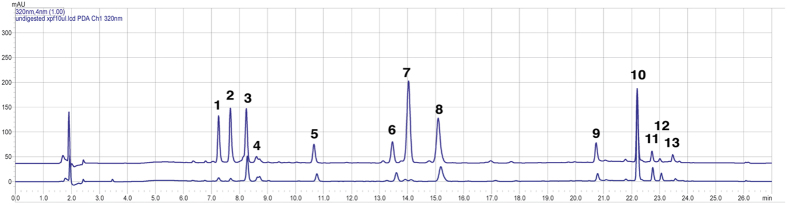
Identification of extractable constituents of A. thaliana mutant xpf3 extract, pre- and post-treatment with liver microsomes.HPLC traces of the constituent chemicals from xpf3 extracts pre and post-liver microsome (LM) treatment yielded component peaks (numbered 1–13). The upper trace is analysis for post-LM extract, the lower trace represents undigested (pre-LM) extract.